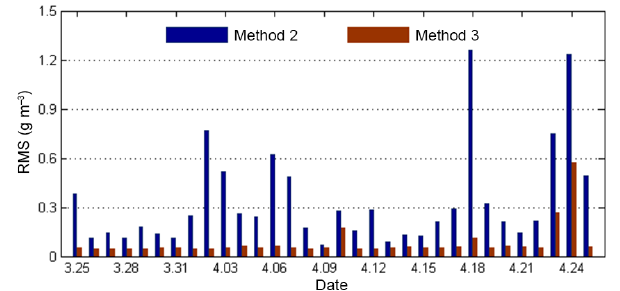
Figure 6. Internal accuracy of the unit scale factor models used for methods 2 and 3 in the experiment.